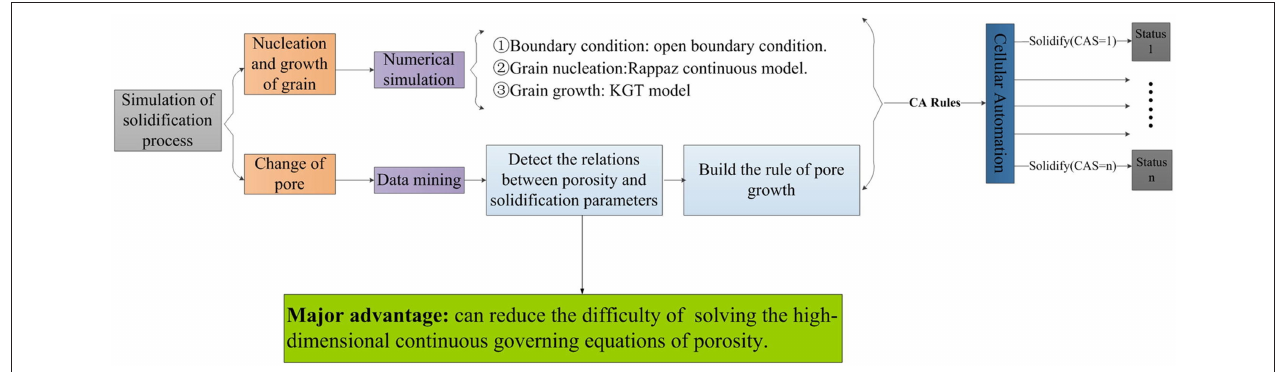
FIGURE 7 | Schematic illustration of the cellular automaton backpropagation neural network (CA-BPNN) method for simulation of the solidification process of aluminum alloys during casting. The simulation is divided into two parts: grain growth and pore growth. For the simulation of grain growth, conventional numerical methods are used; whereas for the pore growth simulation, a BPNN was used to efficiently provide complementary rules for the CA. Reprinted from Hu et al. (2018), Copyright (2018), with permission from Elsevier.